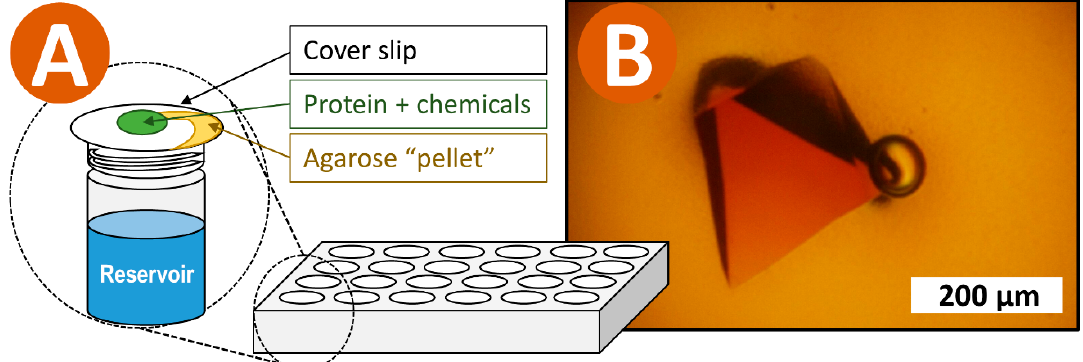
Figure 1. Crystallization using gel exclusion. ( A ) The gel exclusion setup that was used to crystallize test proteins (the shape of the agarose pellet shown was particularly important for ferritin). ( B ) Example of a ferritin crystal grown by gel exclusion (these crystals diffracted to ~1.5 Å resolution).